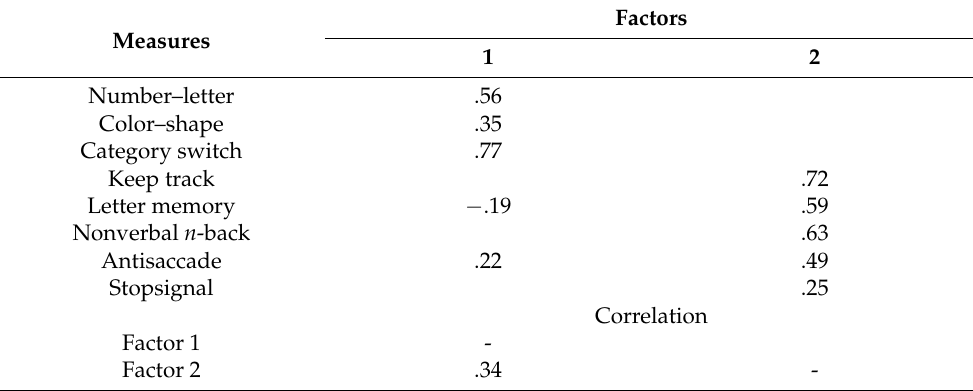
Table A1. Factor loadings for the exploratory factor analysis of all EF variables ( n =